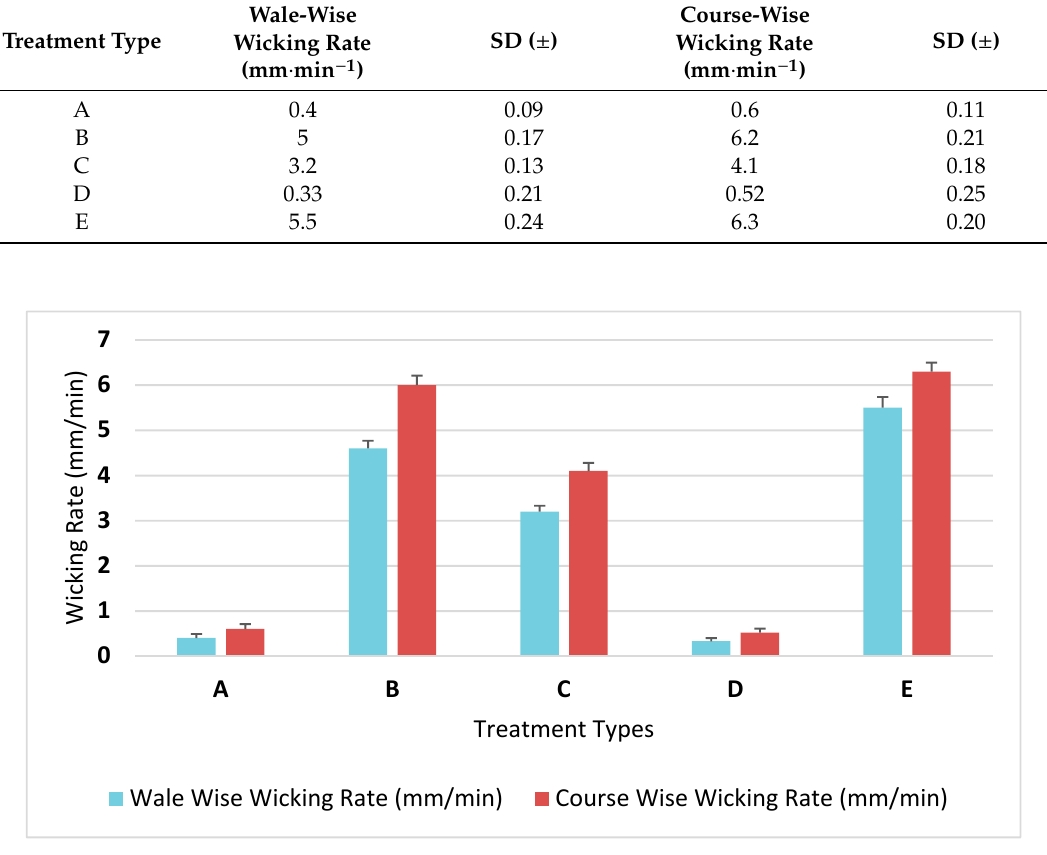
Figure 5. Effect of finishes treatments on wale-wise and course-wise vertical wicking behavior of 100% polyester weft-knitted jersey fabric. (A) Grey fabric, (B) simple wash, (C) normal finish, (D) silicon finish, and (E) wicking finish .